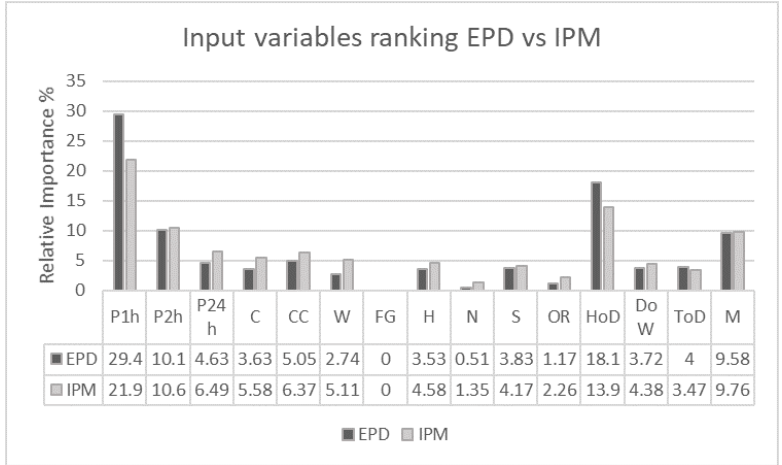
Figure 17. Input variables ranking EPD vs.